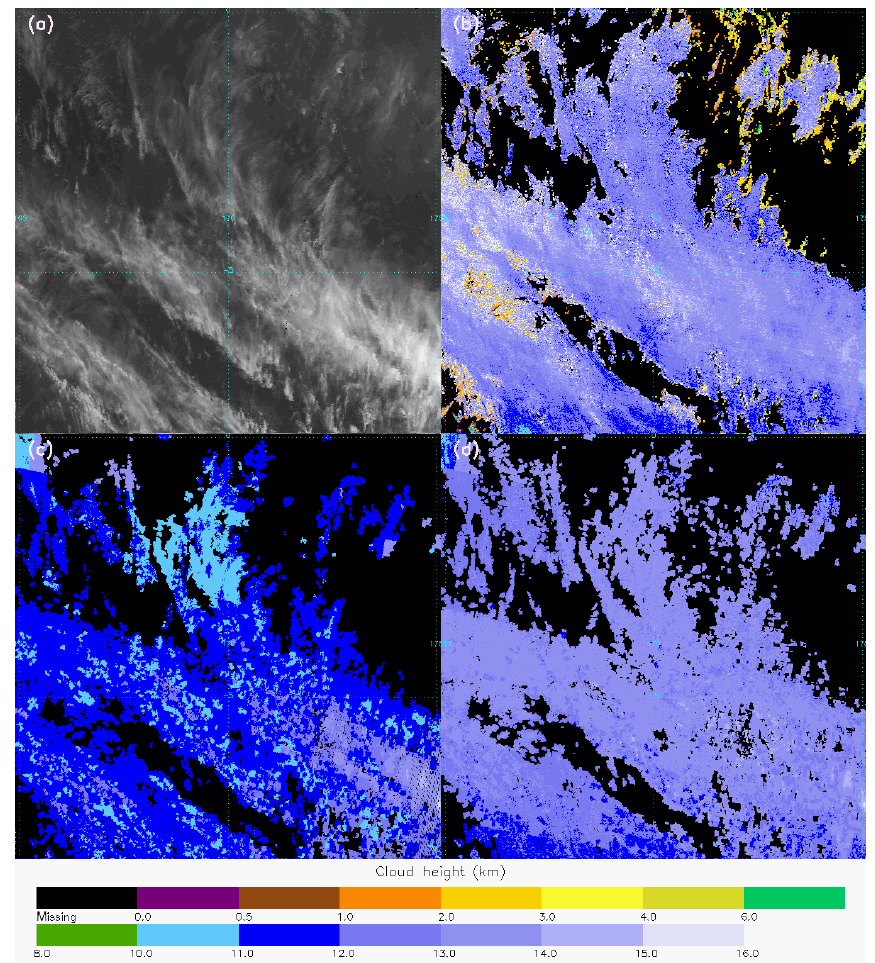
Figure 3. A cirrus cloud scene over the tropical Pacific showing (a) brightness temperature from S-NPP VIIRS, (b) MODIS C6.1, (c) no- fusion VIIRS, and (d) fusion cloud top height for ice clouds